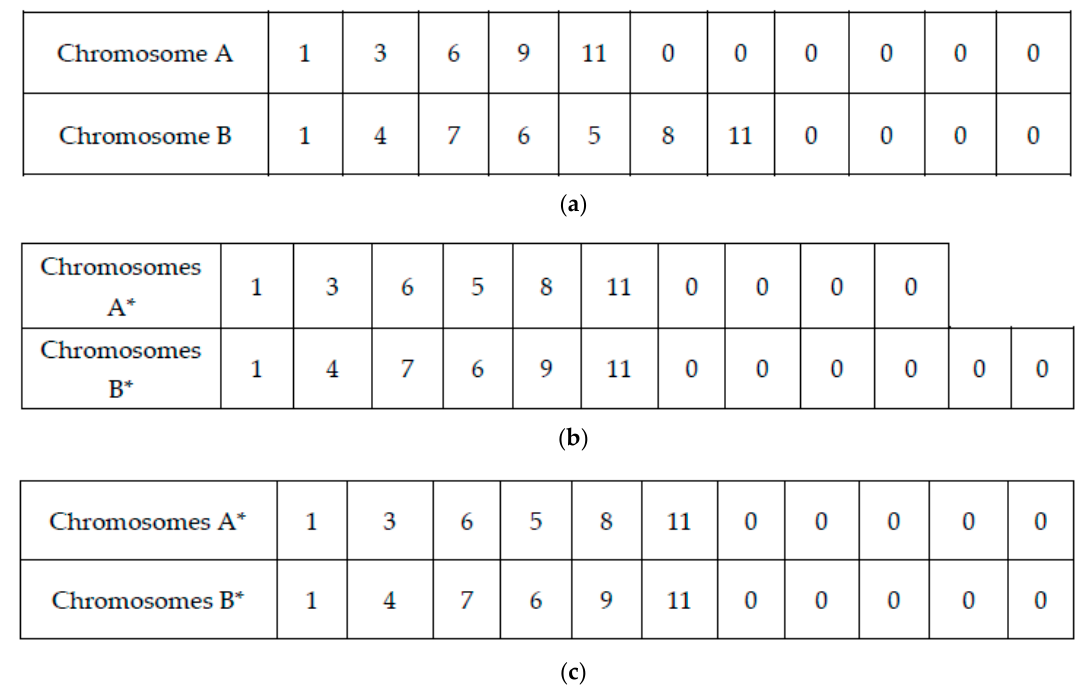
Figure 4. Operation diagram of chromosome crossover. ( a ) Chromosome A and B before crossing; ( b ) chromosomes A* and B* after crossing; and ( c ) chromosome A* and B* after complement and delocation.